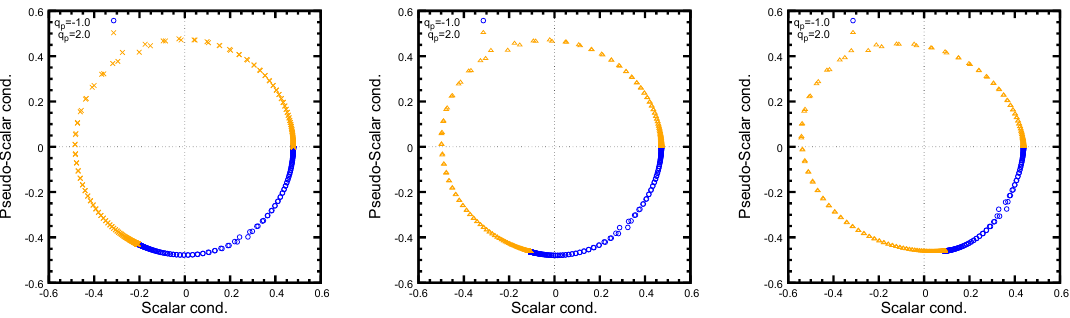
Figure 9 . Scalar and pseudo-scalar condensates in complex plane. The lattice size is ( N, a ) = (801 , 0 . 05) in all plots. The mass parameters are m lat = 0 . 00 , 0 . 15 and 0 . 45 from left to right panels,